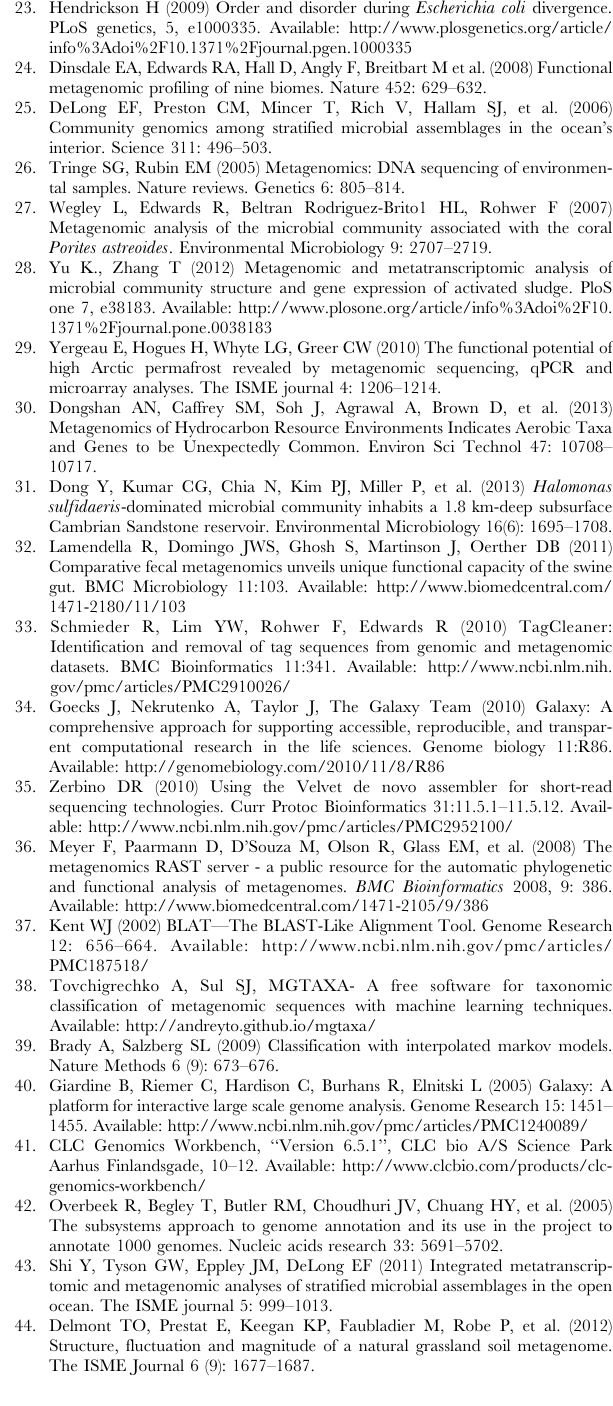
Table S4 Mapping results, (A), for source water, produced water day 1 and produced water day 9 sequencing data against the genome sequences of the dsrA/dsrB gene of selected microbial organisms. Map- ping analysis was performed using CLC Genomics Workbench version 6.5.1 with default parameters. (B) Mapping results for source water, produced water day 1 and produced water day 9 sequencing data against the genome sequences of the apsA gene of selected microbial organisms. Mapping analysis was performed